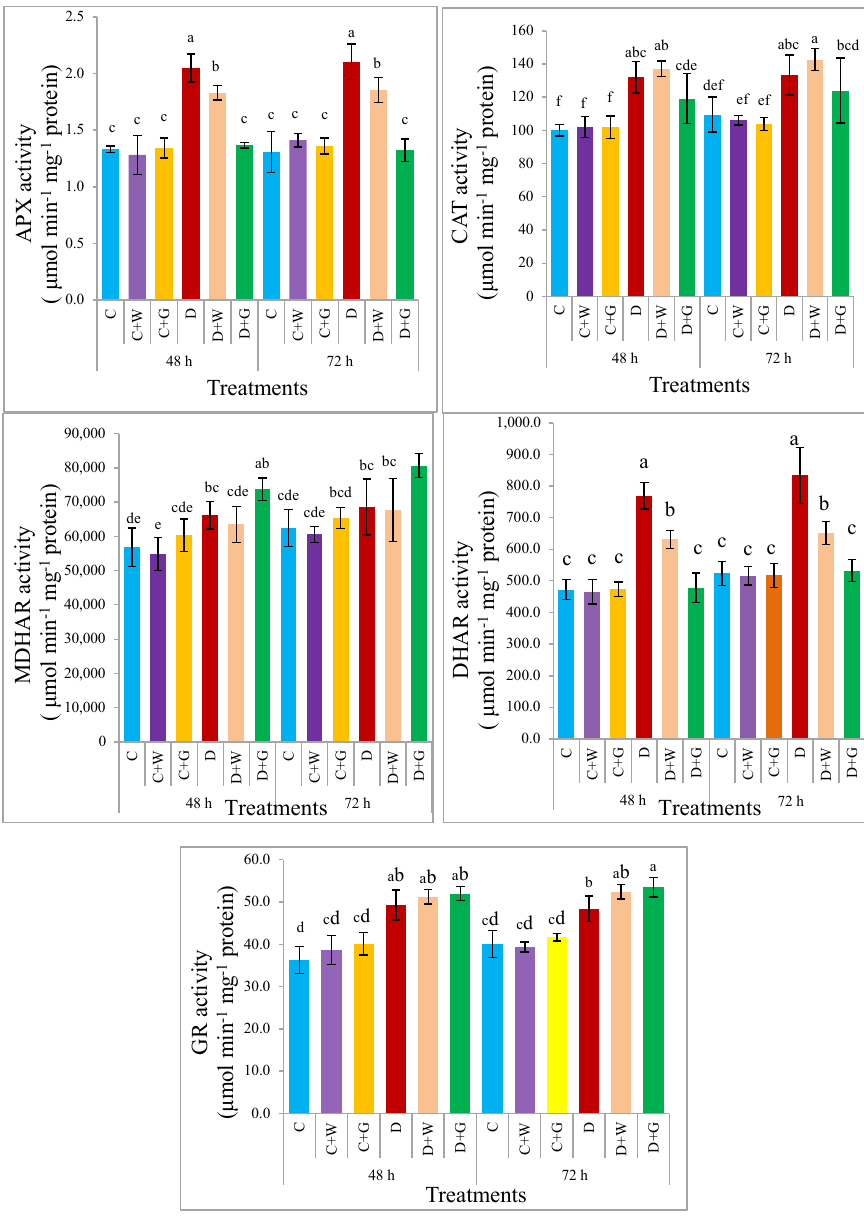
Fig. 5 Effect of drought stress and exogenous GA on AsA-GSH cycle enzymes activity in wheat seedlings. Codes are as for Fig.